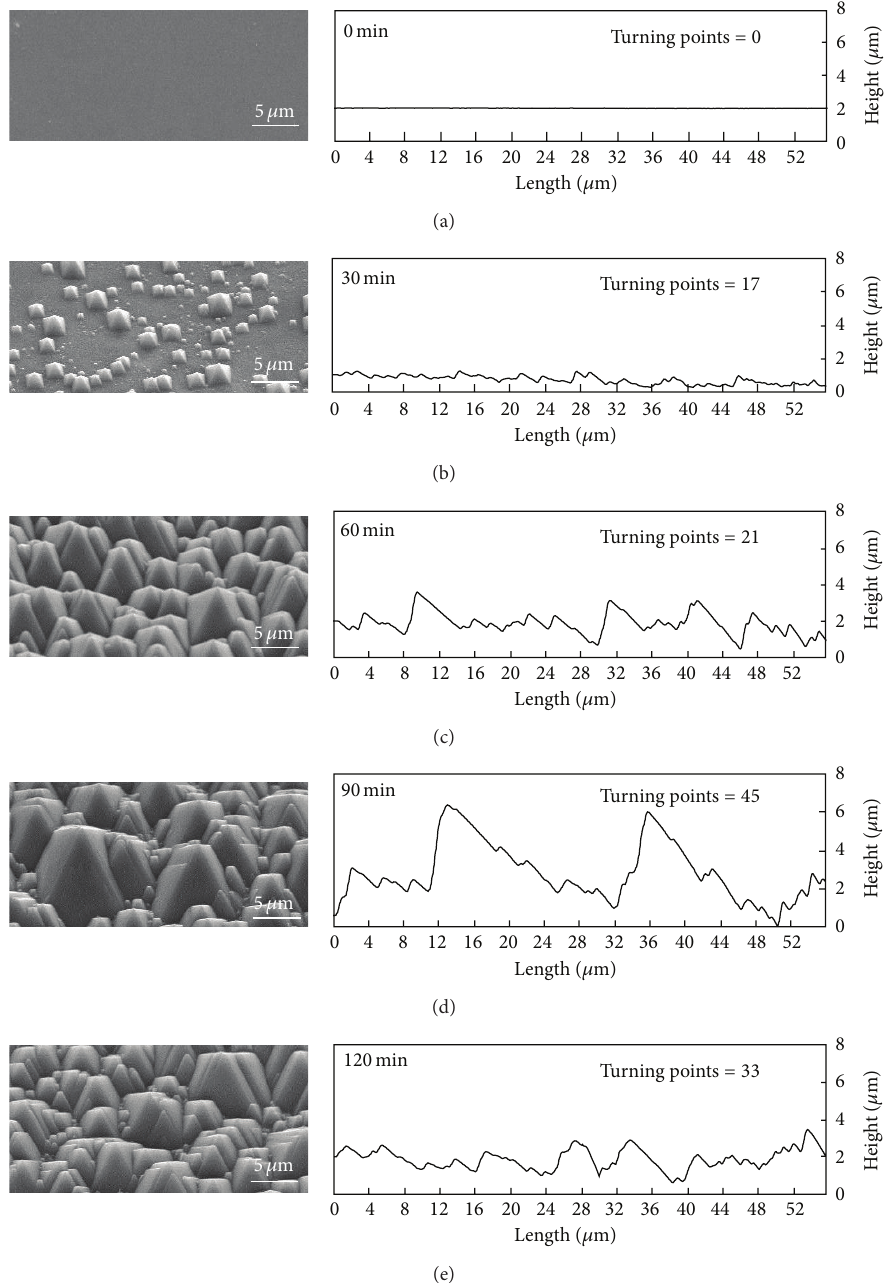
Figure 1: The SEM micrographs and corresponding surface profiles for the wafers with an etching time of (a) 0, (b) 30, (c) 60, (d) 90, and (e) 120